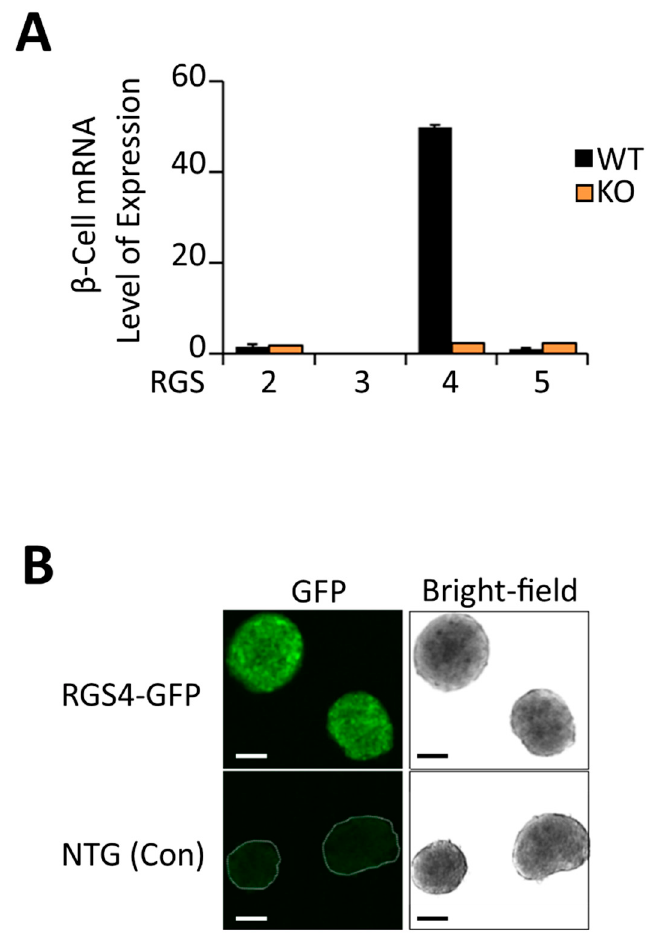
Figure 1. RGS4 is highly expressed in murine pancreatic islets. ( A ) qRT-PCR quantitation of relative RGS protein mRNA expression in wild-type and RGS4-deficient murine pancreatic islets. Data are normalized to 18S ribosomal RNA. ( B ) Bright-field and fluorescent confocal microscopy images of pancreatic islets from wild-type (non-transgenic control) and RGS4-GFP mice. Scale bars denote 100 µm.